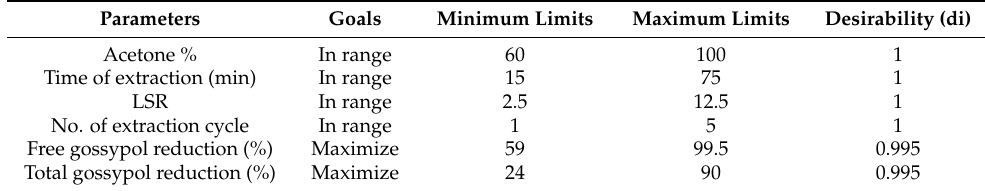
Table 6. Response optimization of the input parameters based on desirability.